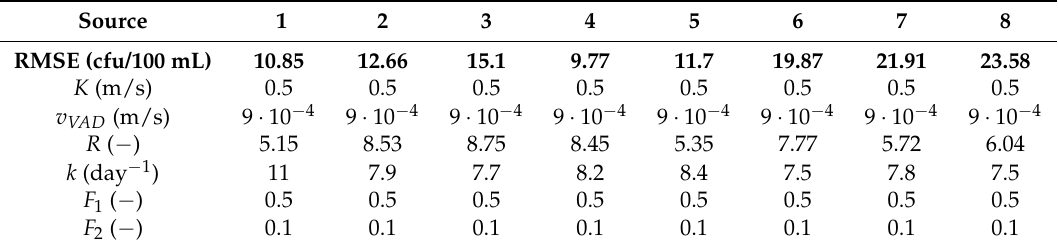
Table 6. Optimal combinations of the variation parameters values with the respective RMSE for each path 1–8 towards Jezerce well.